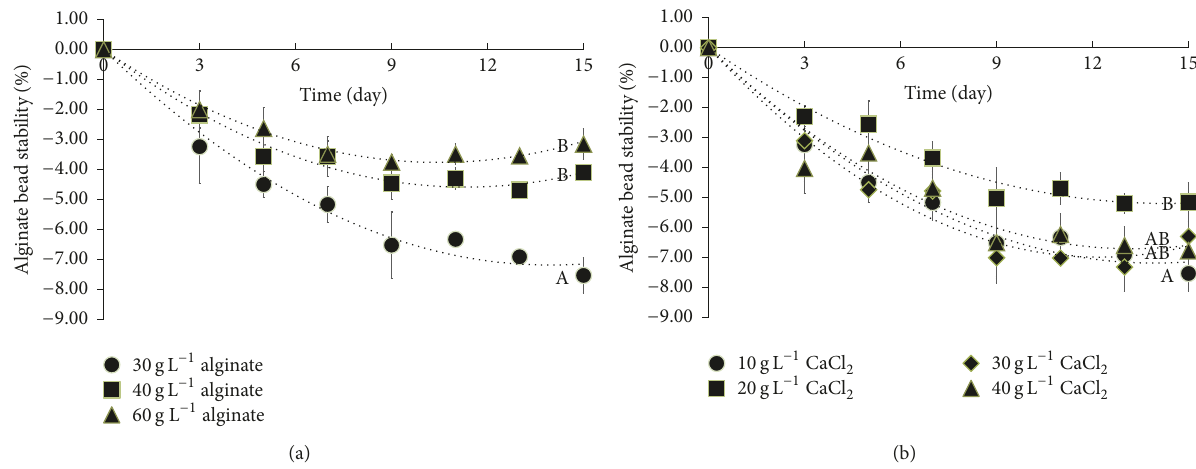
Figure 3: Changes (%) of alginate bead prepared by using different (a) alginate concentrations and (b) hardening by different concentrations ofCaCl 2 solutioninf/2mediumfor15days.Thedifferentletterindicatedsignificantdifference( 𝑝 value ≤ 0.05)betweenalginatebeadprepared by using different (a) alginate concentrations and (b) hardening by different concentrations of CaCl 2 solution at the end of the